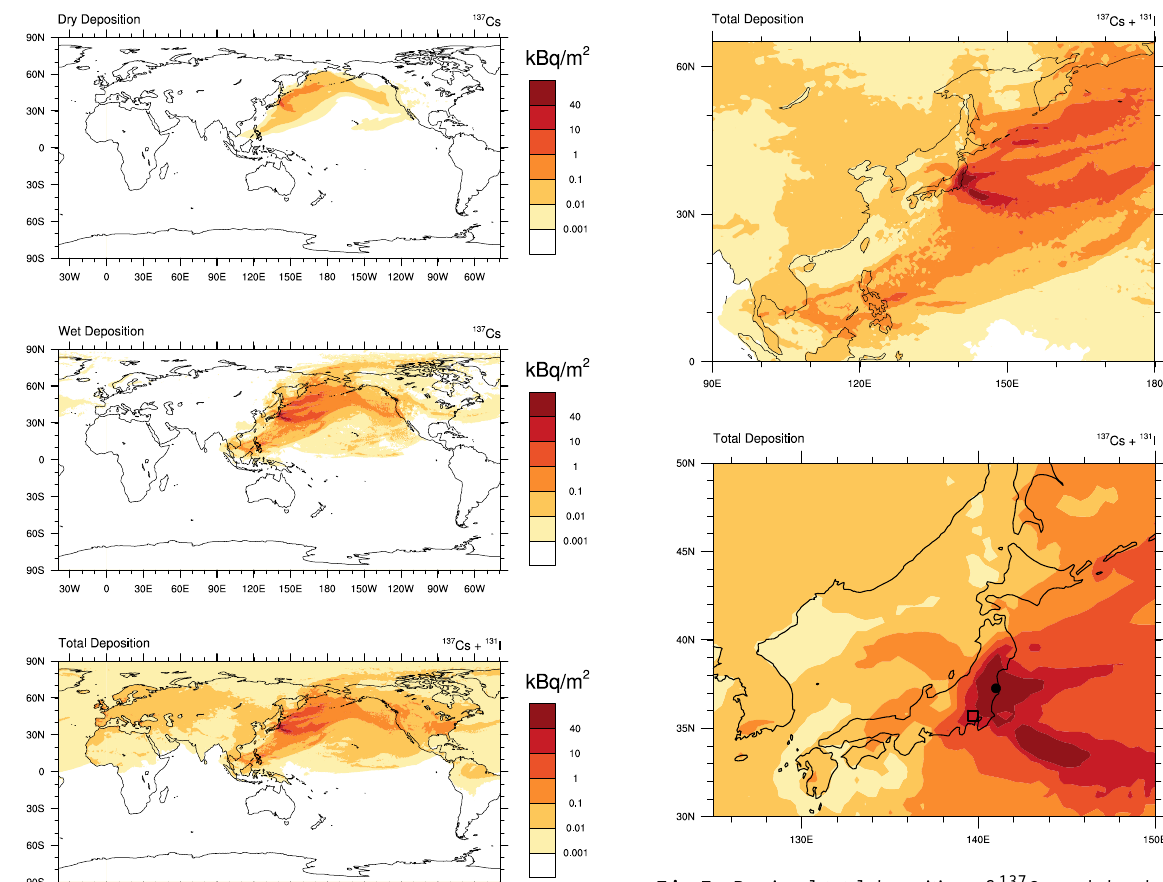
Fig. 7. Regional total deposition of 137 Cs and dry deposition of gaseous 131 I in Bq at different scales. The black point marks the location of the Fukushima nuclear power plant and the rectangle the Tokyo metropolitan area. Contours are on a logarithmic scale. The 40 kBqm − 2 contour lines signify areas that received total deposition greater than the contamination activity level defined by International Atomic Energy Agency (IAEA) (2005, 2009).